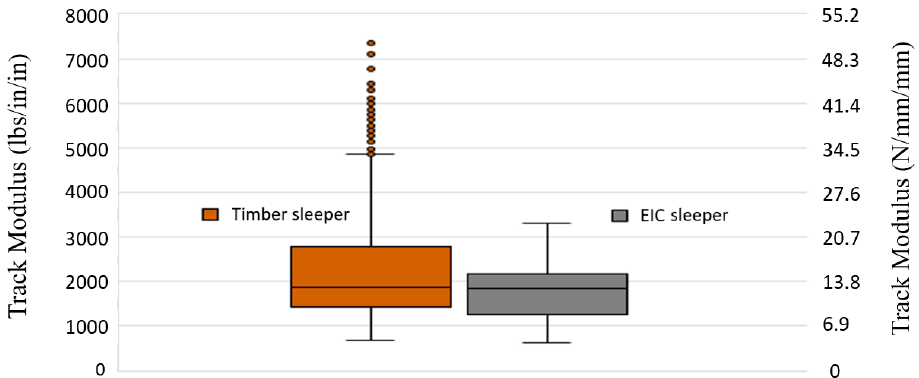
Figure 12. Comparison of the track modulus between the timber and EIC sleepers, considering all measured locomotive and passenger coach field data.